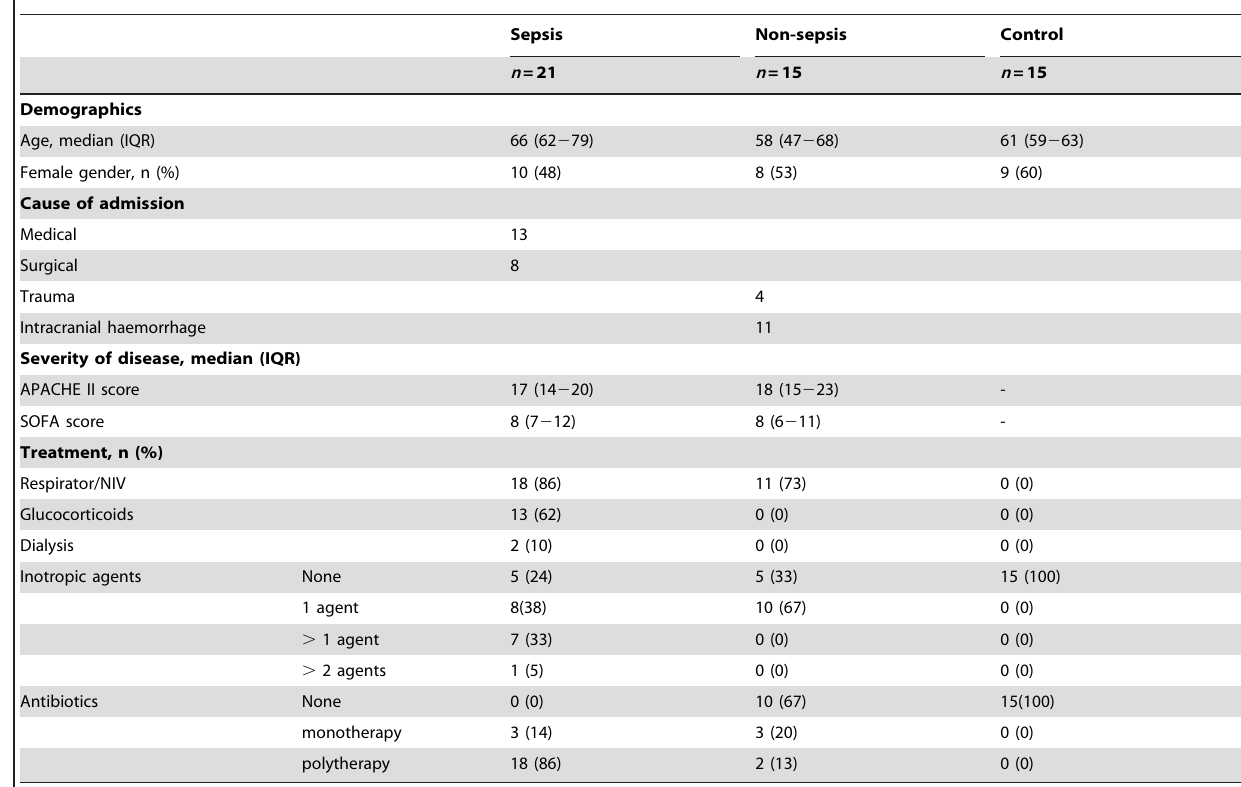
Table 1. Patient